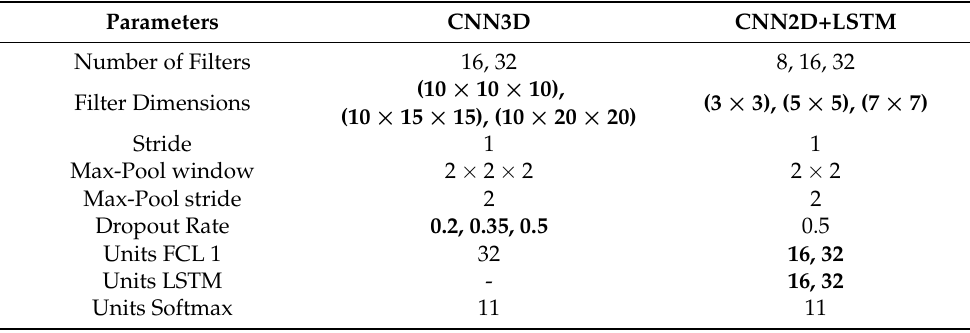
Table 3. CNN Parameters. Hyper-parameters are shown in